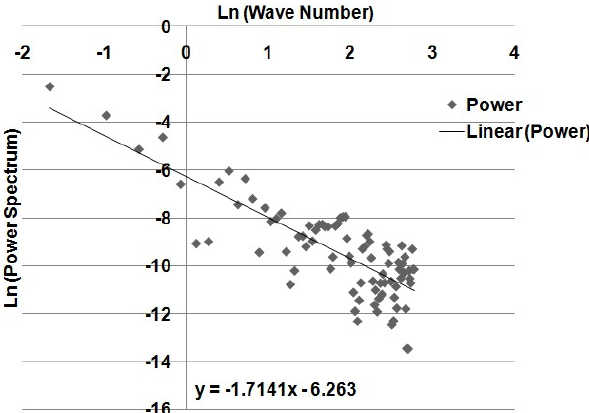
Fig. 2. Log-log plot of power spectrum of heat production data vs. wave number for the Northeastern Baltic shield. Suitable linear equation was fit to the data to obtain the scaling exponent which comes to 1.7 indicating fractal behavior in the data set. Variance in the data is also seen as revealed by scattered data